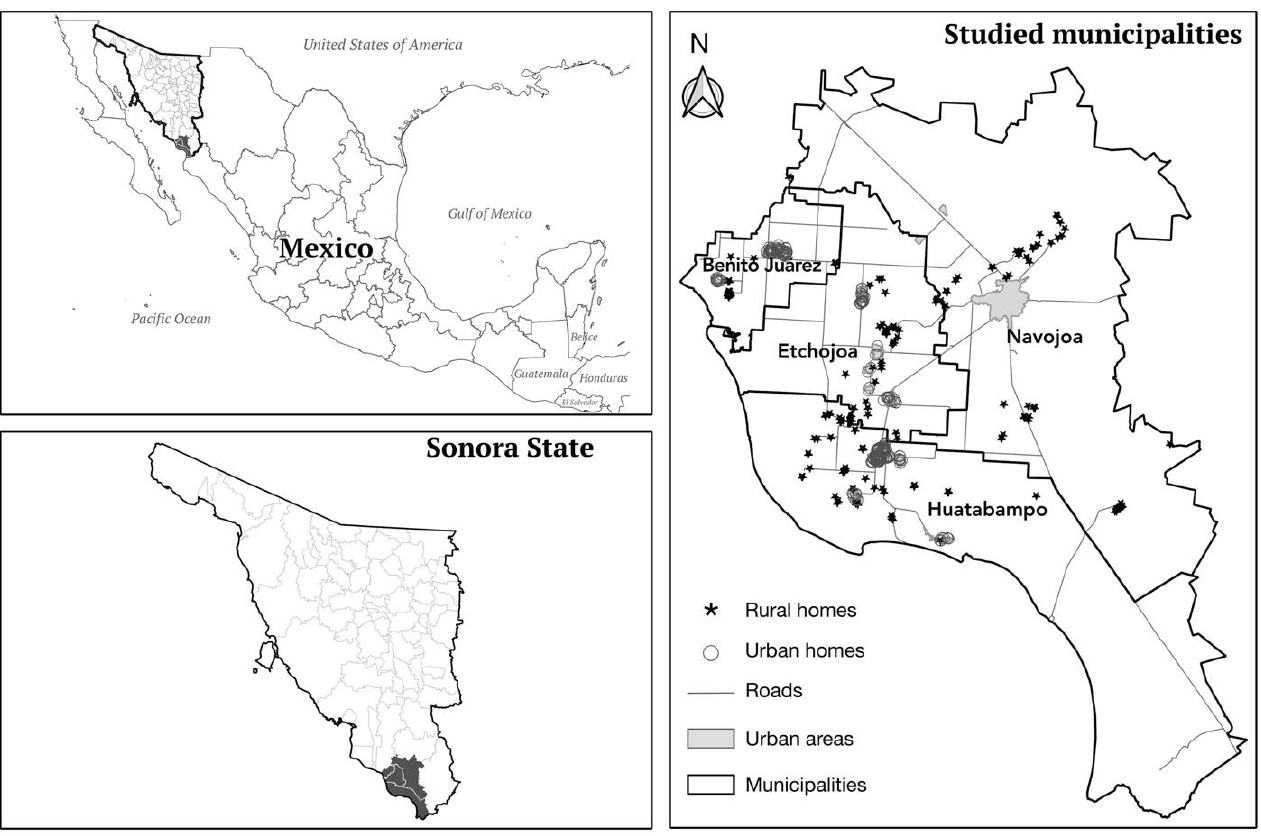
Figure 1. Study site.